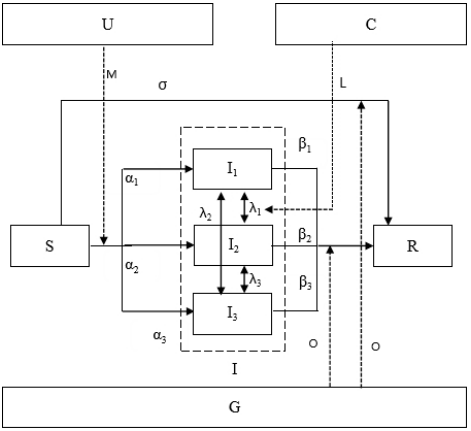
Figure 2. Interactive public opinion communication model in heterogeneous network. Table 1. The meaning of the parameters in model.